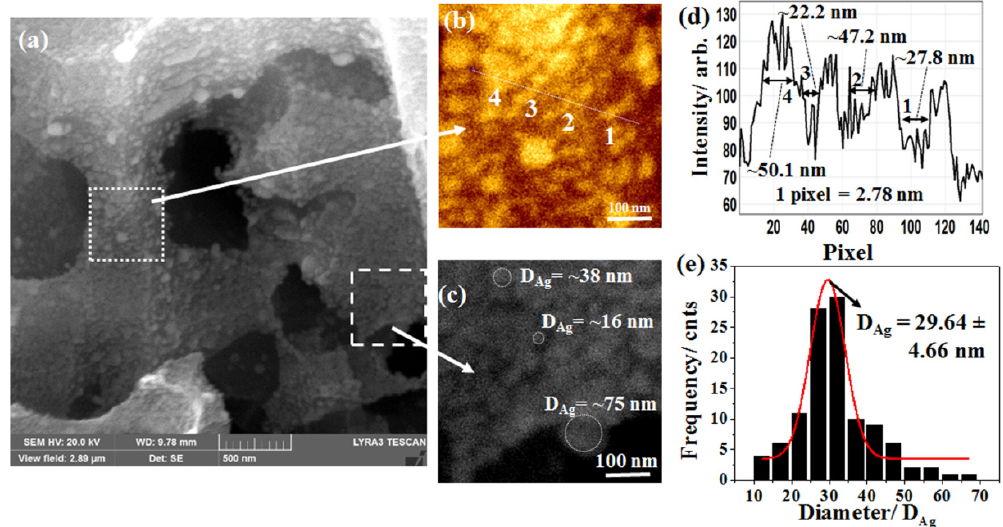
Figure 3. ( a ) High-resolution FESEM micrograph of Ag-decorated terraces in Si-NSs, ( b ) Zoom-in view of a small area (500 nm × 500 nm) as marked by the white dotted square in ( a ), ( c ) Zoom-in view of another small area (500 nm × 500 nm) as marked by the white dotted square in Figure 3a confirming different sizes and shapes of Ag-NPs, ( d ) Line profile along the white dotted line crossing four typical Ag-NPs marked as 1, 2, 3 and 4 in ( b ), and ( e ) size distribution (black) of Ag-NPs along with Gaussian fit (red).